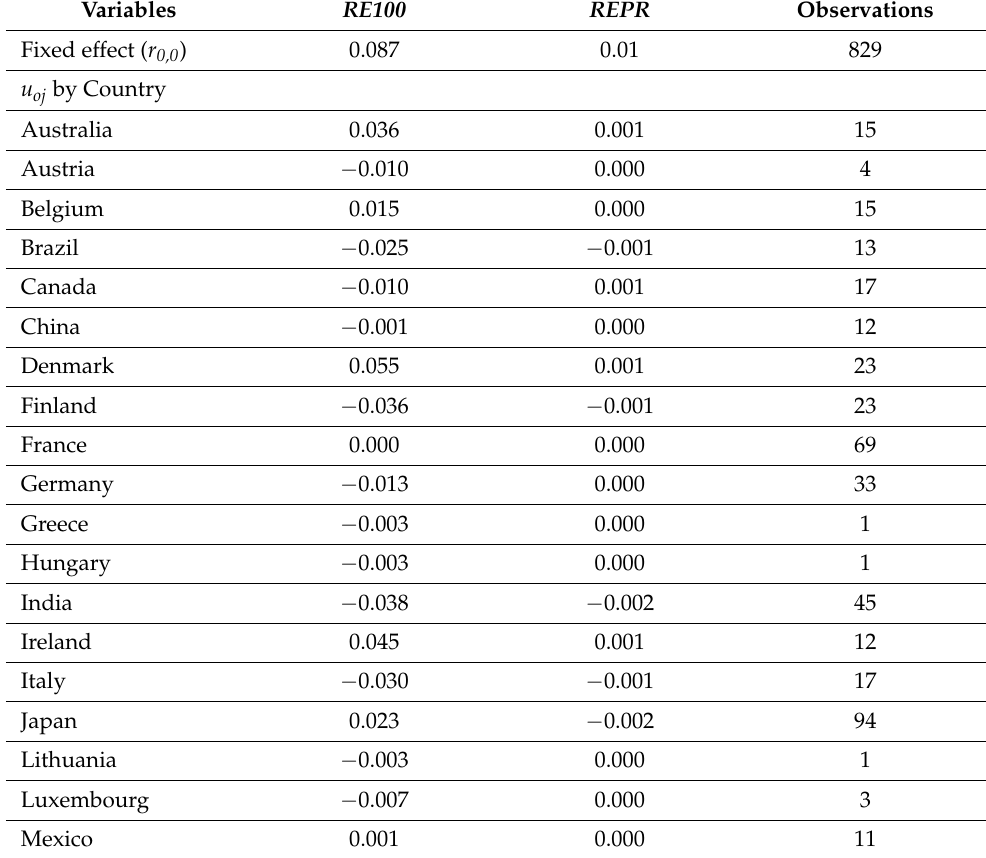
Table 4. The results of null model estimates under the HLM by